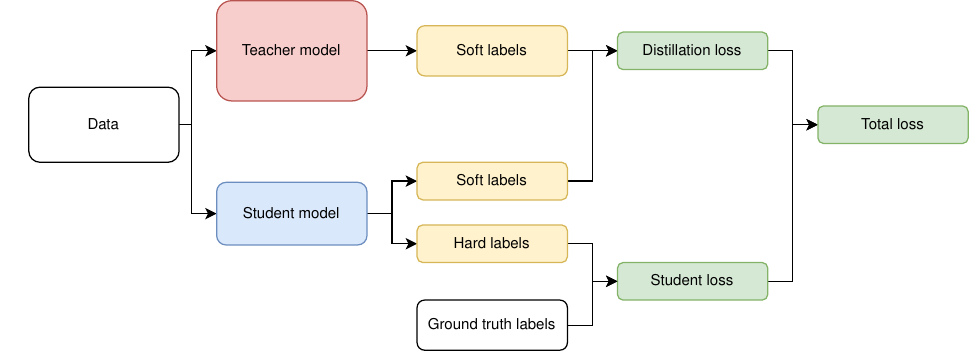
Figure 4. Response-based knowledge distillation.